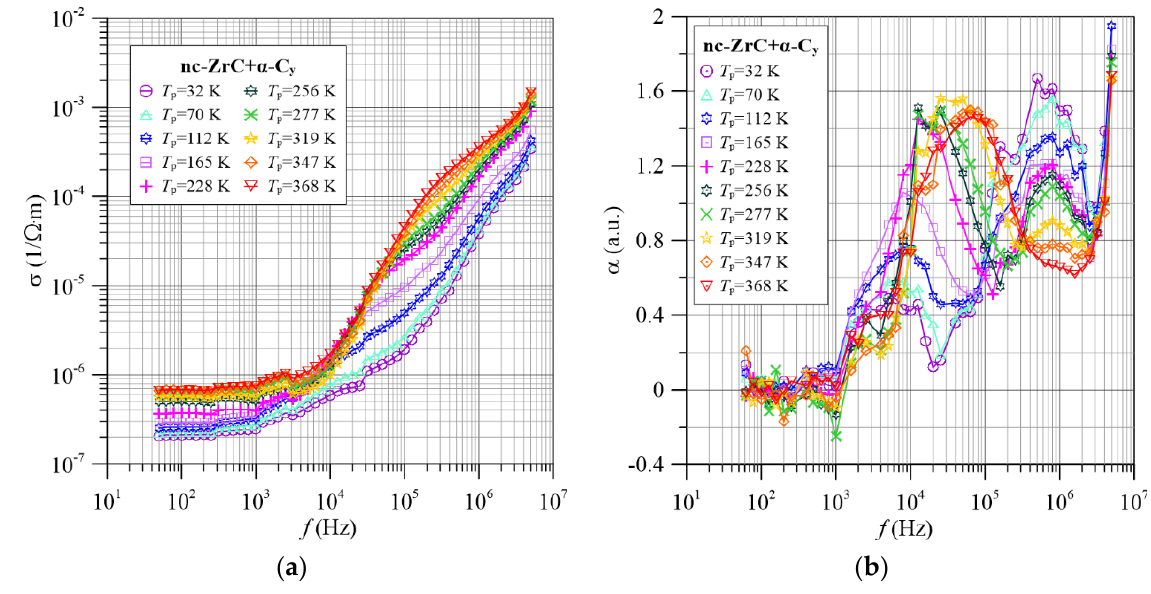
Figure 8. Frequency dependence of conductivity ( a ) and frequency factor α ( f ) ( b ) for selected measurement temperatures for the nc ‐ ZrC+ α‐ C y nanocomposite.